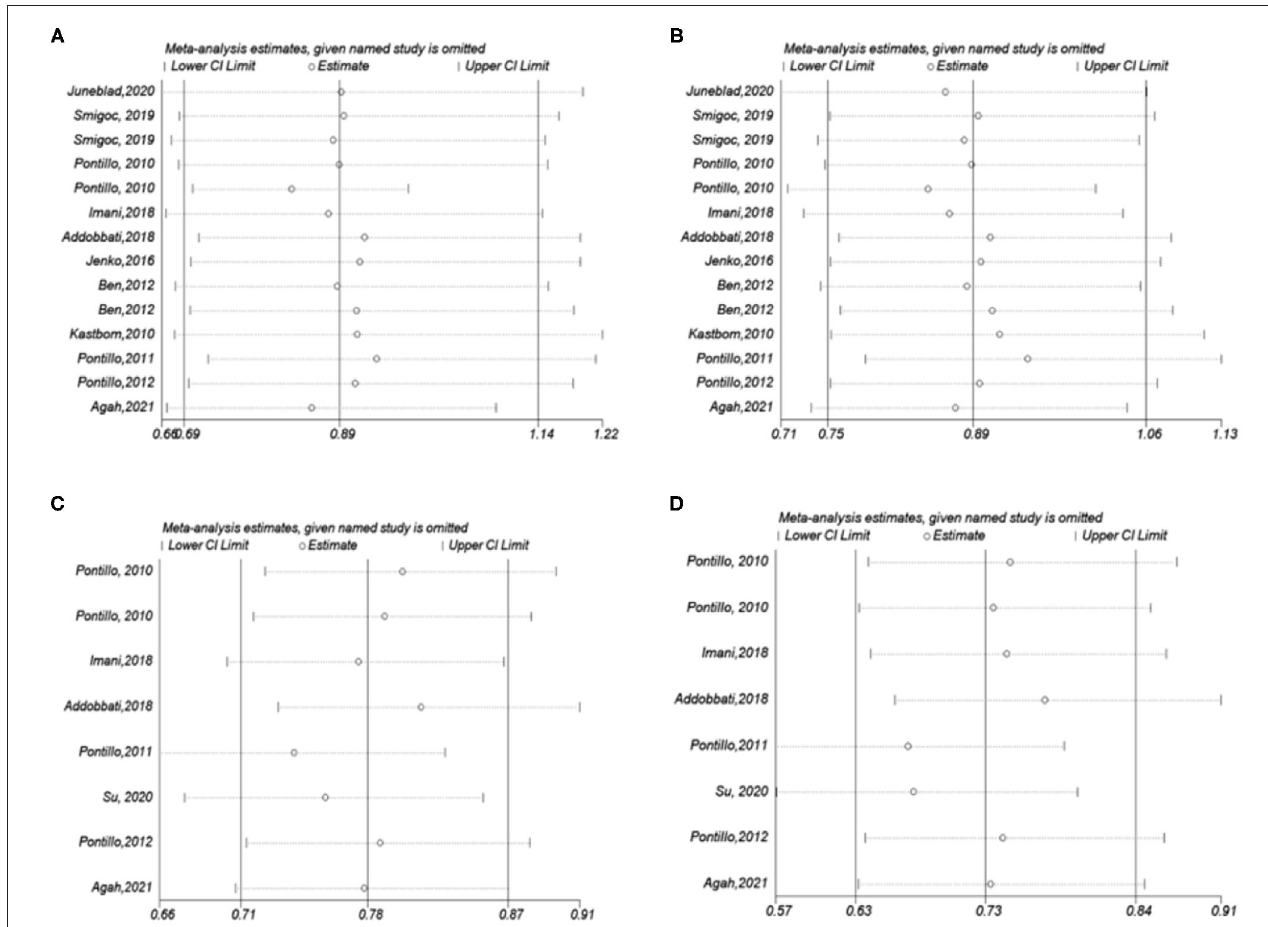
FIGURE 4 | Influence analysis for NLRP3 SNPs in the overall meta-analysis. The middle vertical axis indicates the overall OR and the other two vertical axes indicate the 95% CI. (A) A vs. C for rs35829419; (B) AA/AC vs. CC for rs35829419; (C) G vs. C for rs10754558; (D) GG/GC vs. CC for